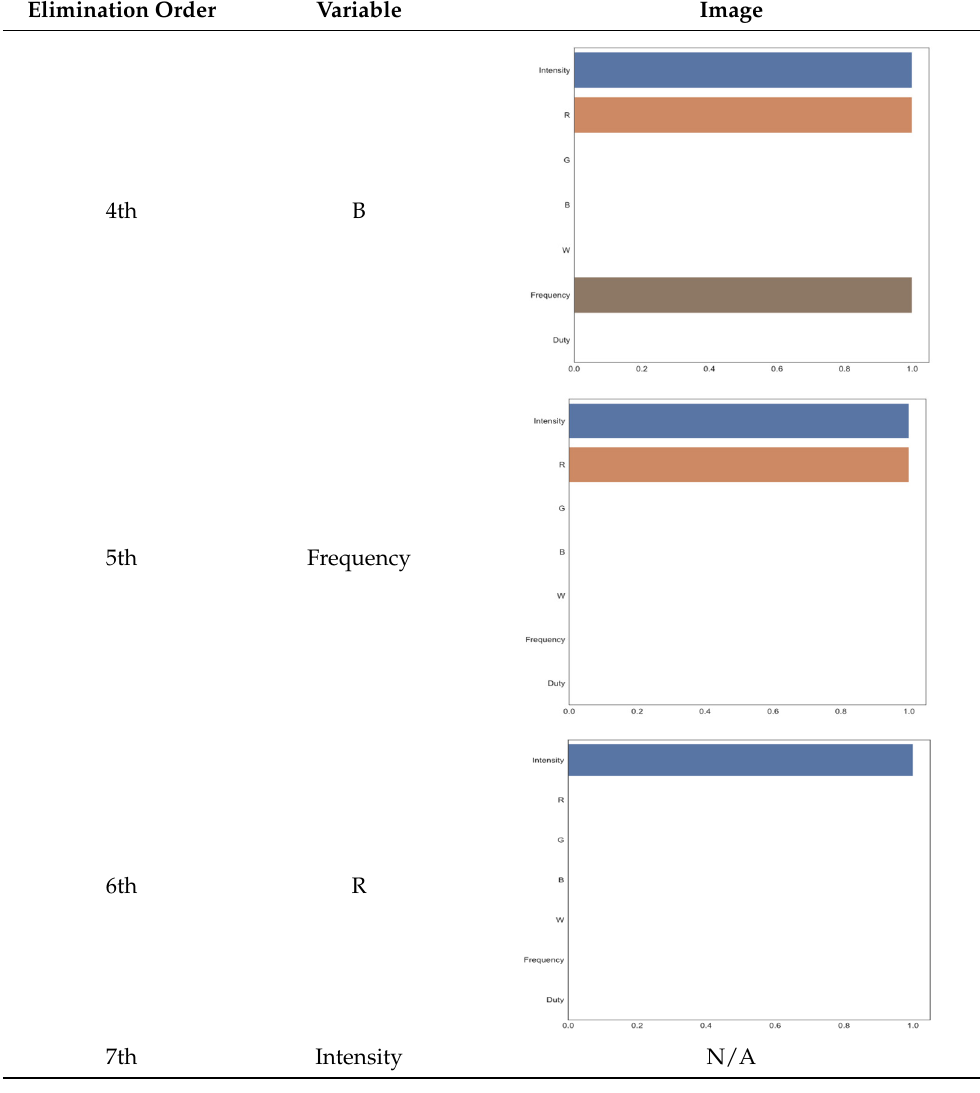
Table 8. Sequential feature selection by decision tree for depth =